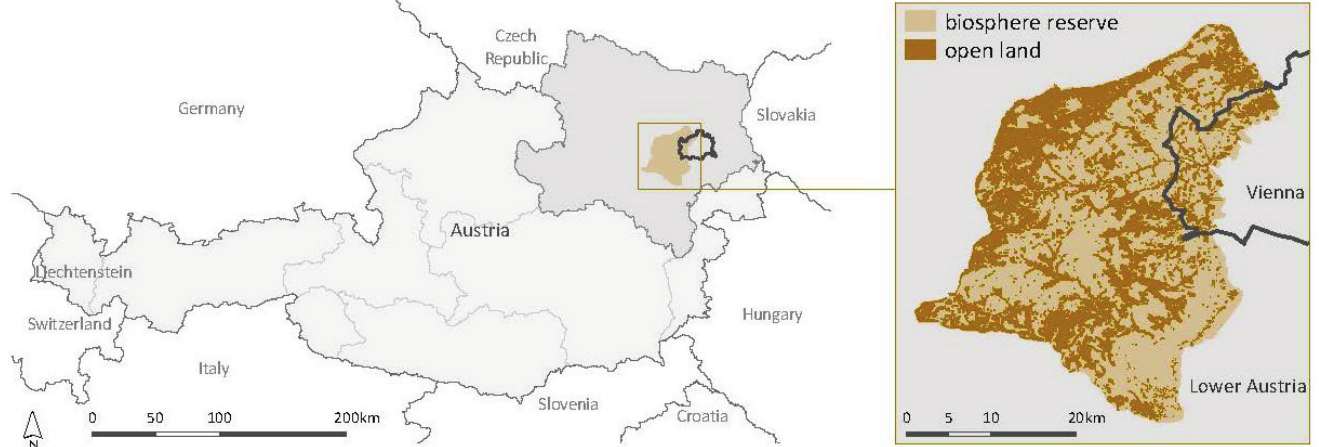
Figure 1: Study area: the open land of the Wienerwald Biosphere